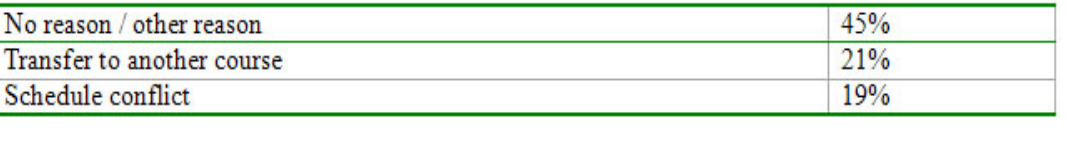
Table 8 . Top three reasons for withdrawal from online classes, accounting for 85 percent of the